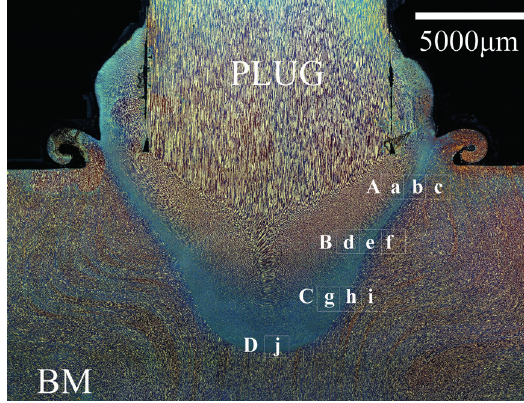
Figure 8: Microstructure 25 kN zones divided into regions.